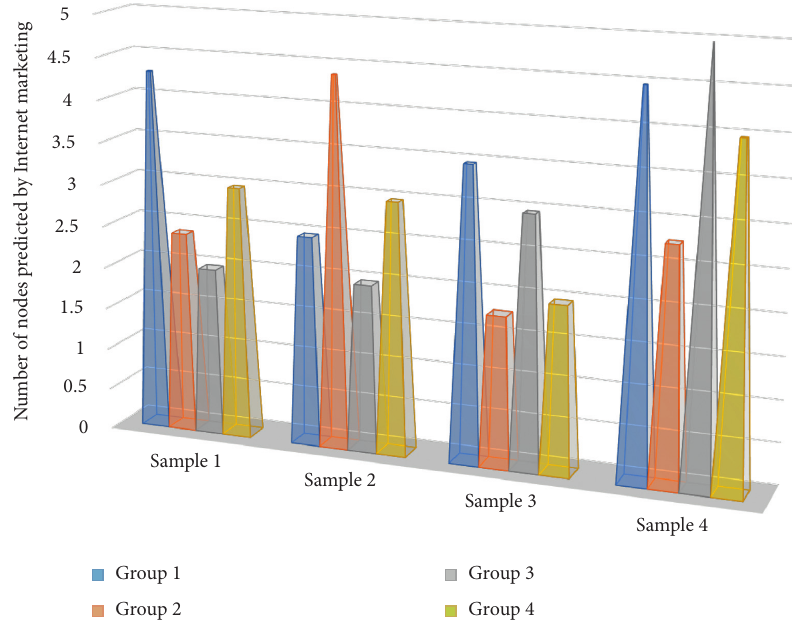
Figure 2: Classification of Internet marketing forecast